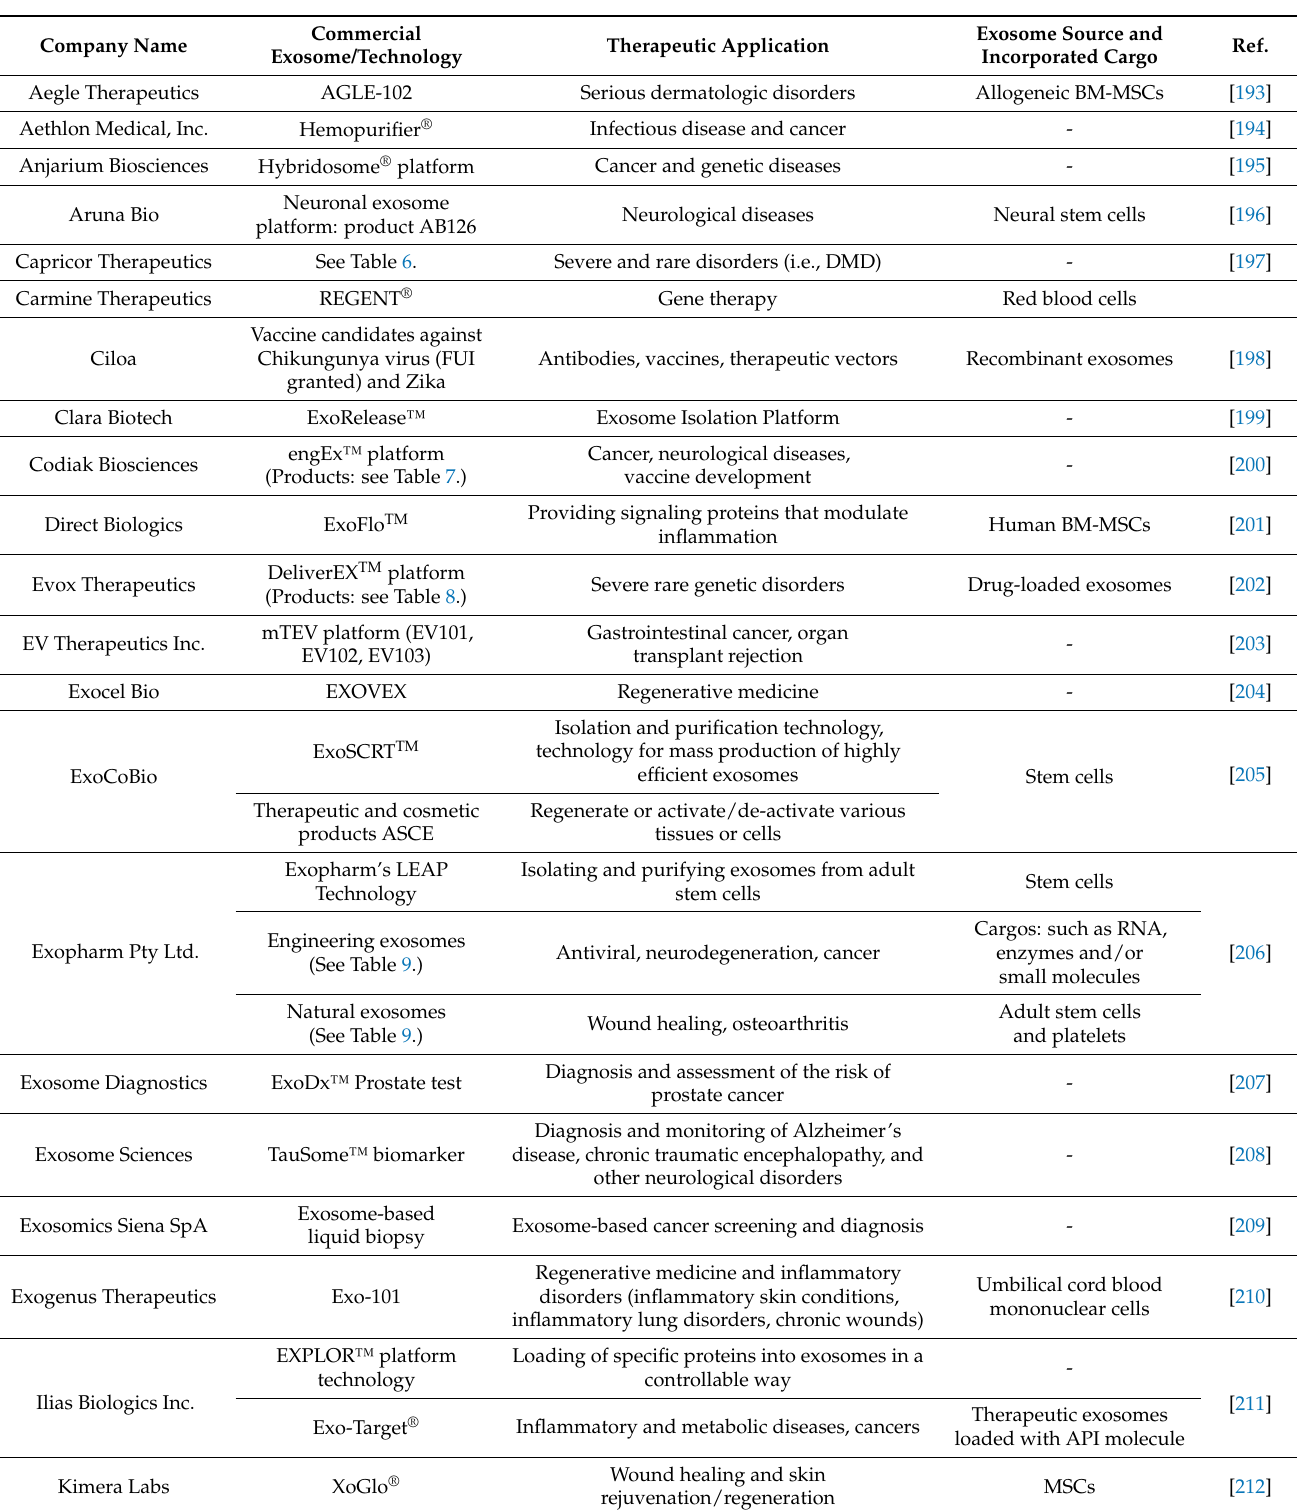
Table 5. Commercial companies using